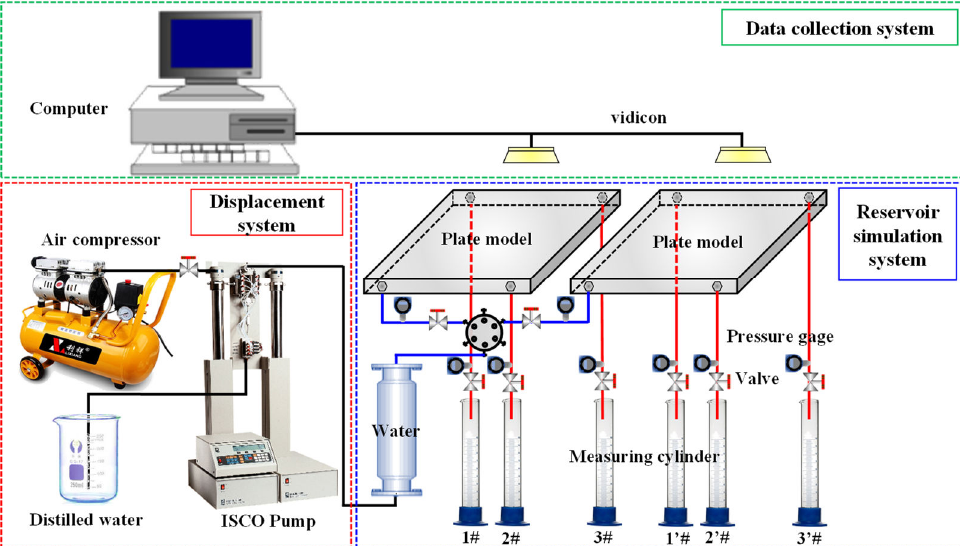
Figure 3. Schematic diagram of the connection of each device of the two-dimensional visualization experiment of dual-plate water drive. This device includes three systems: the data collection system, the displacement system, and the reservoir simulation system.